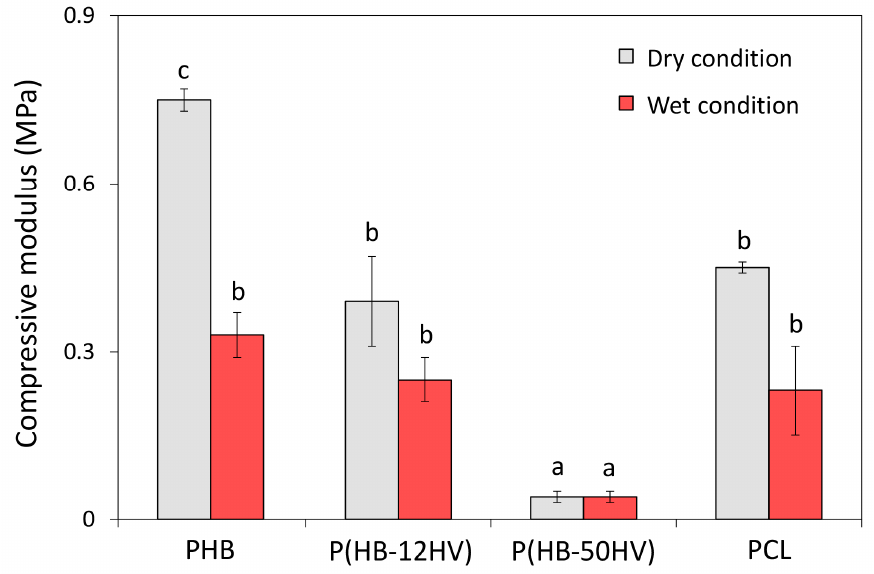
Figure 4. Compressive secant modulus at 30% strain compared between the dry and wet conditions. Data are reported as the average values from six independent scaffolds with standard deviations ( n = 6). The different letters (a, b, and c) above the bar graph indicate significant differences ( p < 0.05) between the scaffold materials tested under the same conditions.